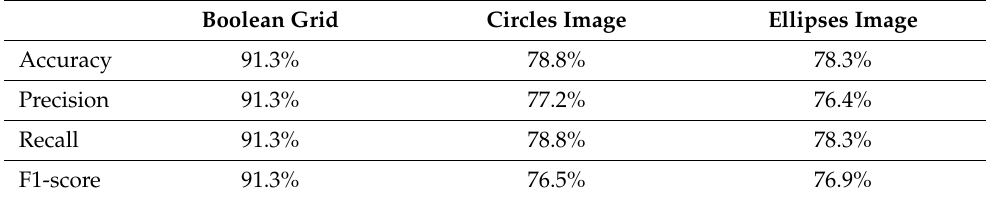
Table 5. Classification results for the activity detection using the 3 variants of data representation. Boolean Grid Circles Image Ellipses Image Accuracy 91.3% 78.8% 78.3% Precision 91.3% 77.2% Recall 91.3%